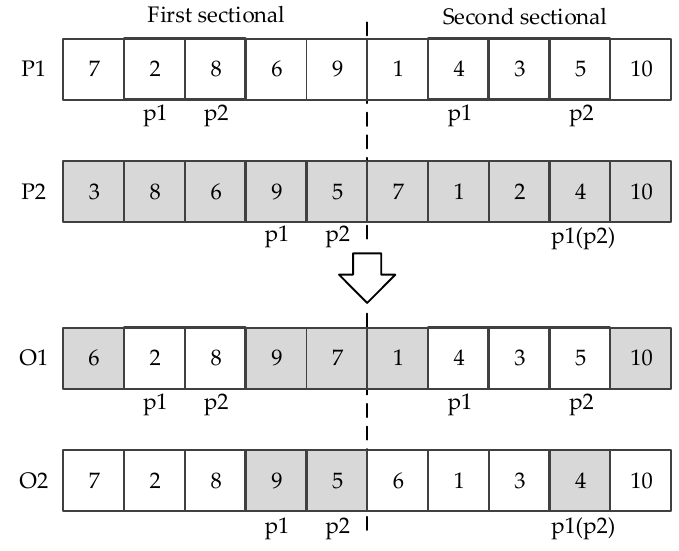
Figure 7. Schematic diagram of sectional